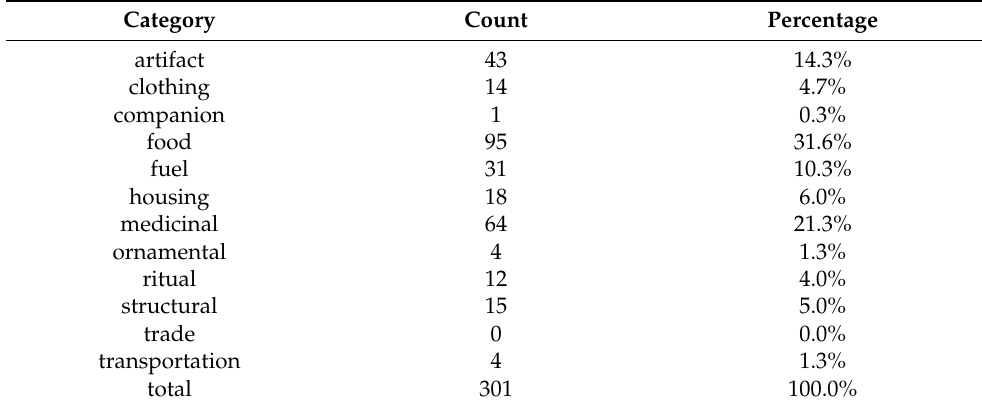
Table 3. Frequency of representation for each use type.